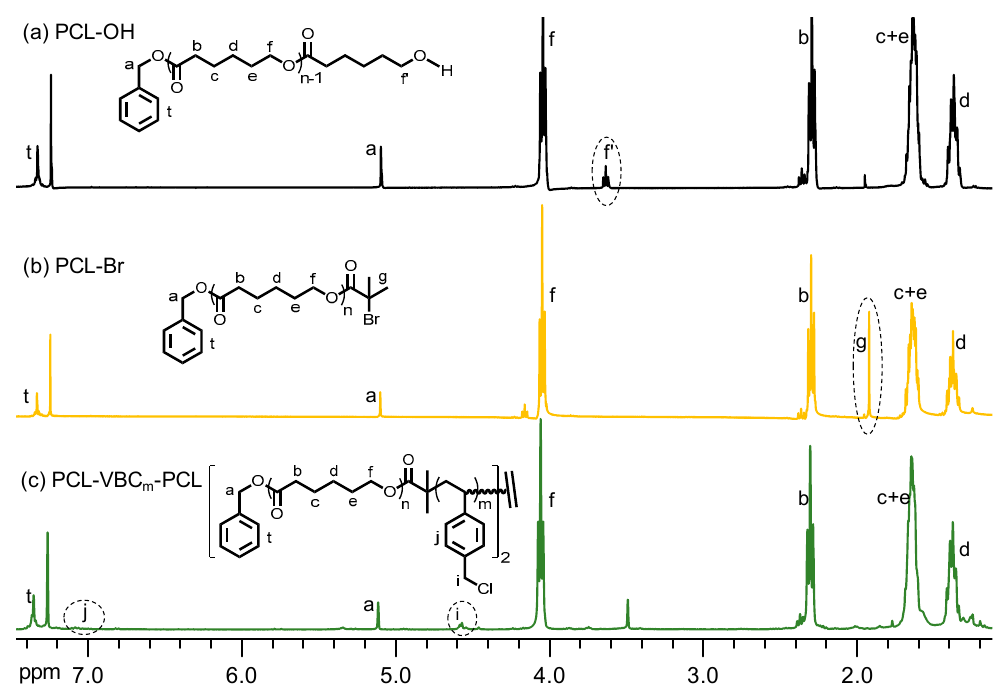
Figure 2. 1 H NMR spectra (400 MHz, CDCl 3 ) of ( a ) PCL–OH, ( b ) PCL–Br, and ( c ) PCL-VBC m -PCL.